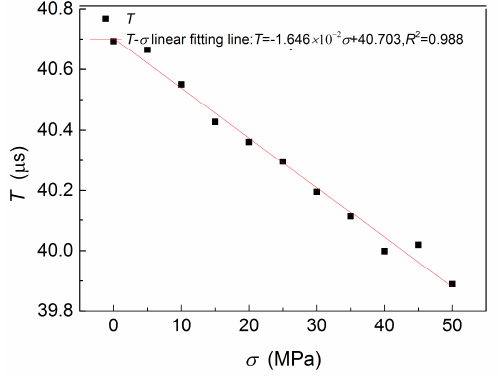
Figure 5. Propagation time T of the specimen A under 0 – 50 MPa stress.